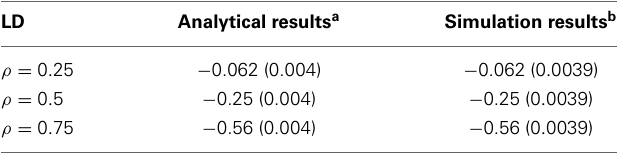
LD Analytical results a Simulation results b